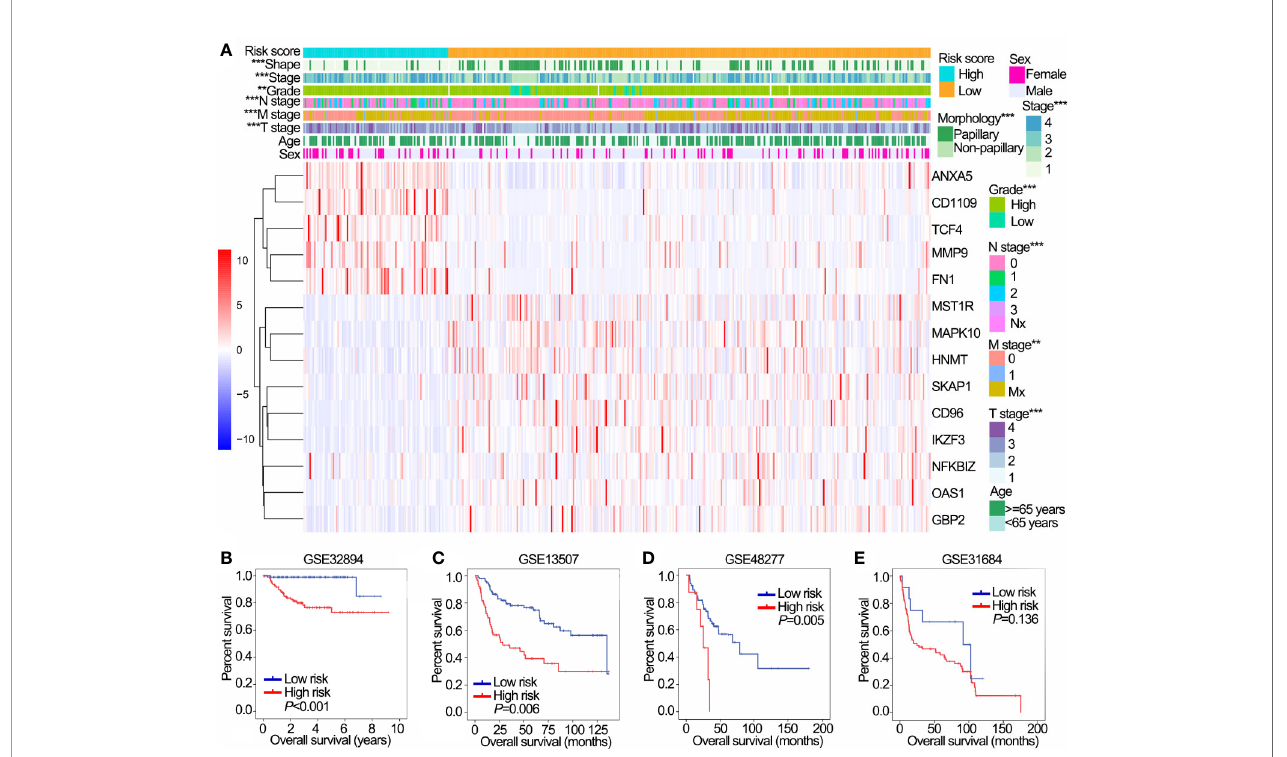
FIGURE 4 | Prognostic value of the IPS in training (TCGA) and validation (GSE32894, GSE13507, GSE48277 and GSE31684) data sets. (A) The heatmap shows the expression levels of 14 OS-associated immune genes in low and high risk groups in TCGA data sets. The distribution of clinicopathological features were compared between low and high risk groups. (B – E) Kaplan-Meier OS curves for patients assigned to high and low risk groups in GSE32894 (B) , GSE13507 (C) , GSE48277 (D) and GSE31684 (E) data sets. ** P < 0.01, *** P < 0.001. IPS, immune prognostic signature; TCGA, The Cancer Genome Atlas; OS, overall